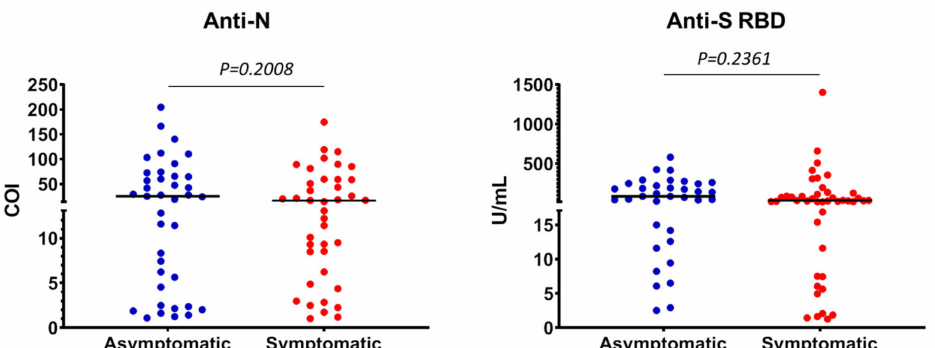
Figure 2. Plasma levels of anti-N (left) and anti-S RBD (right) antibodies in participants from the National and Kapodistrian University of Athens (NKUA) with asymptomatic and symptomatic SARS-CoV-2 infection. Each circle represents values (cutoff index (COI) or Units (U)/mL) from a single participant. Horizontal bars indicate median values (Mann-Whitney test).